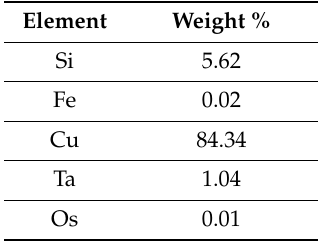
Table 1. Element and weight percentage of energy dispersive spectroscopy (EDS).